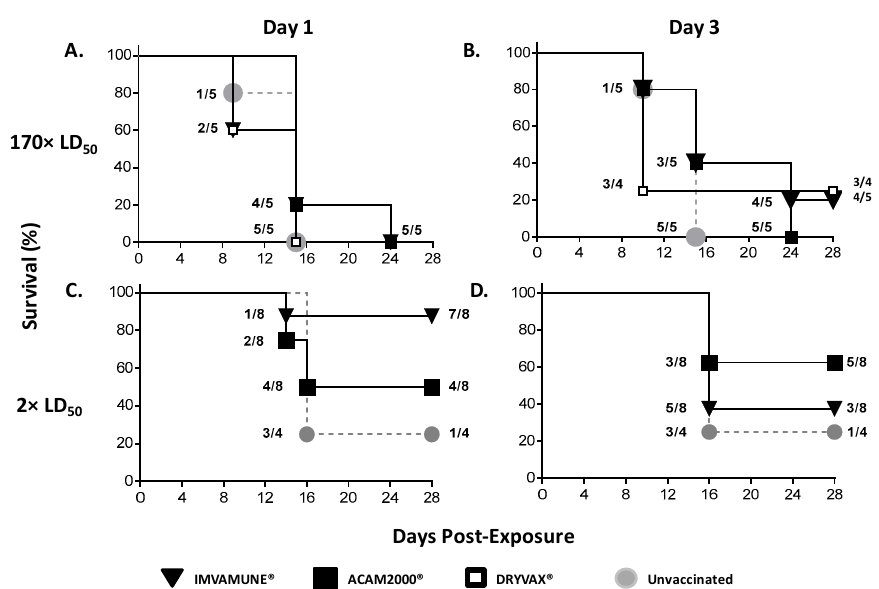
Figure 2. Survival benefits of post-exposure vaccination. Kaplan–Meier survival curves are shown for animals challenged with 170 × LD 50 dose and vaccinated on Day 1 ( A ) or Day 3 ( B ) postexposure with Dryvax ® (white squares), ACAM2000 ® (black squares), IMVAMUNE ® (black triangles), or PBS (gray circles). Animals challenged with a 2 × LD 50 dose of MPXV and vaccinated 1 ( C ) or 3 ( D ) days postexposure with ACAM2000 ® (black squares), IMVAMUNE ® (black triangles), or unvaccinated (gray circles) are also shown. Fractions represent the cumulative number of animals censored at each time-point over the total numbers of animals in each group. Some symbols are sized differently for clarity of superimposed data. When compared to the unvaccinated control survival curve, none of the vaccinated survival curves showed statistically significant differences by log-rank (Mantel–Cox) test ( p > 0.05).